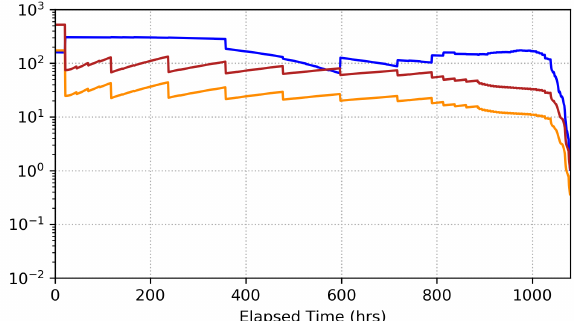
Figure 8. Position error (blue) and RTPC uncertainty (1- σ (orange) and 3- σ (red)) for optical-only filter in Small Optical Bias setup.